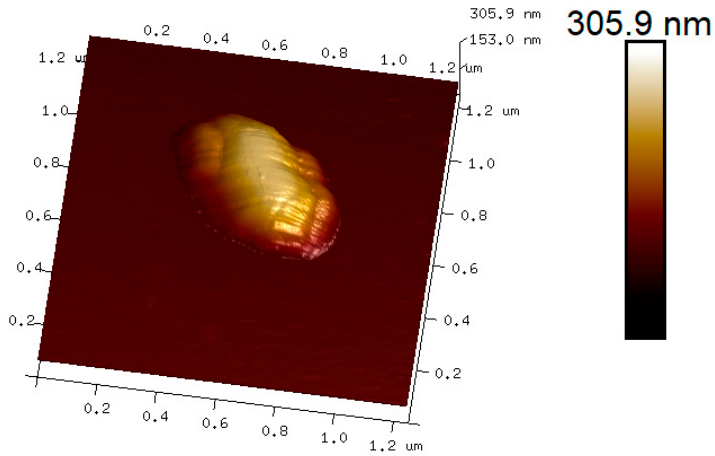
Figure 4. Side view of a morphological image by atomic force microscopy (AFM) for a single ZnO nanorod.